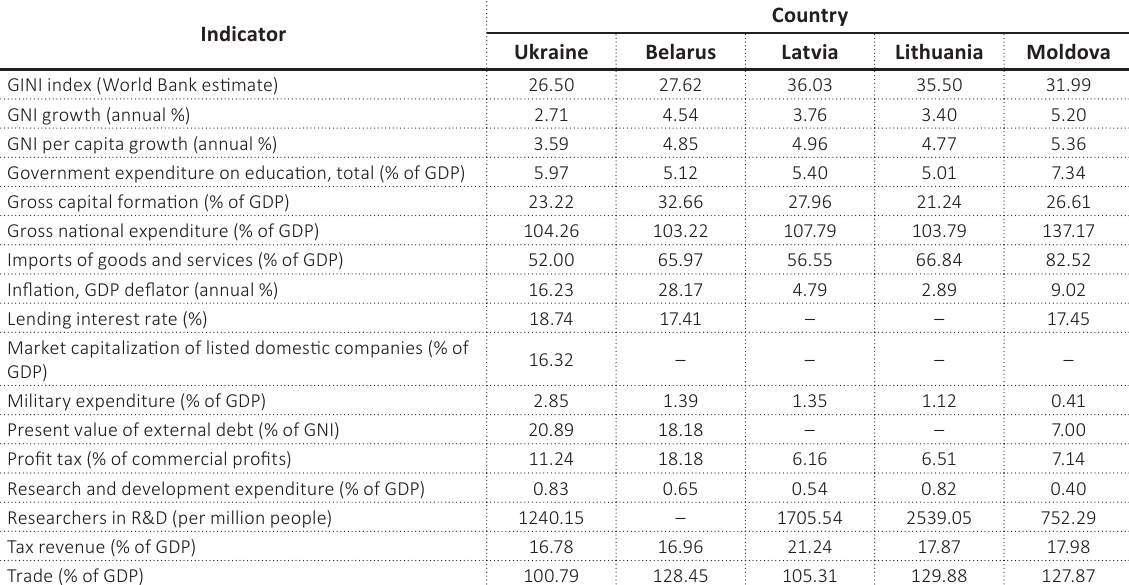
Table 2 (cont.). General indicators of development of the studied countries’ economies on average